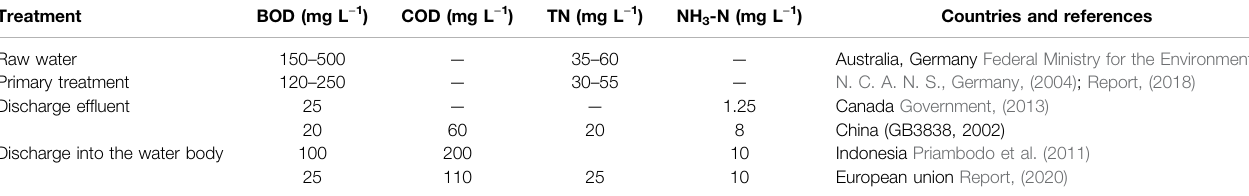
TABLE 1 | Example of guidelines for the discharge of wastewaters from fi sh processing in various countries.